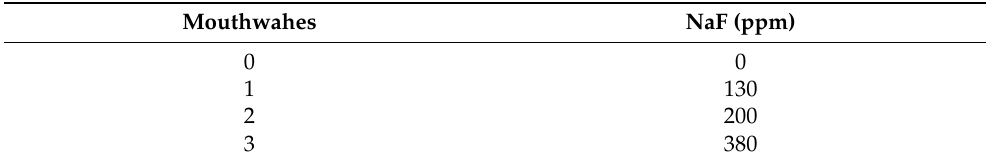
Table 2. NaF composition of the different mouthwashes.